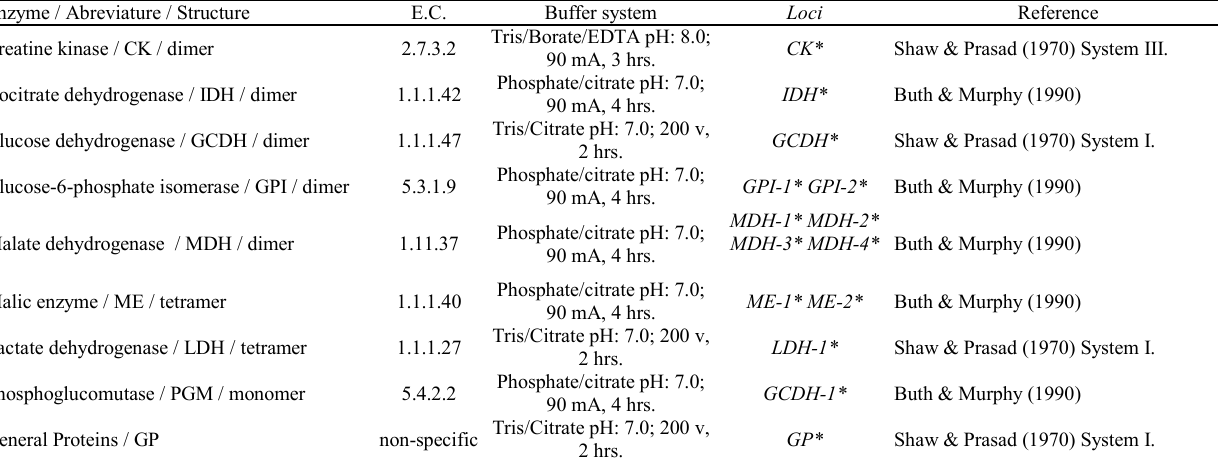
Table 1. Enzyme systems studied, enzyme commission code number, buffer and running conditions, reference, and loci scored for Gephyrocharax and Corynopoma